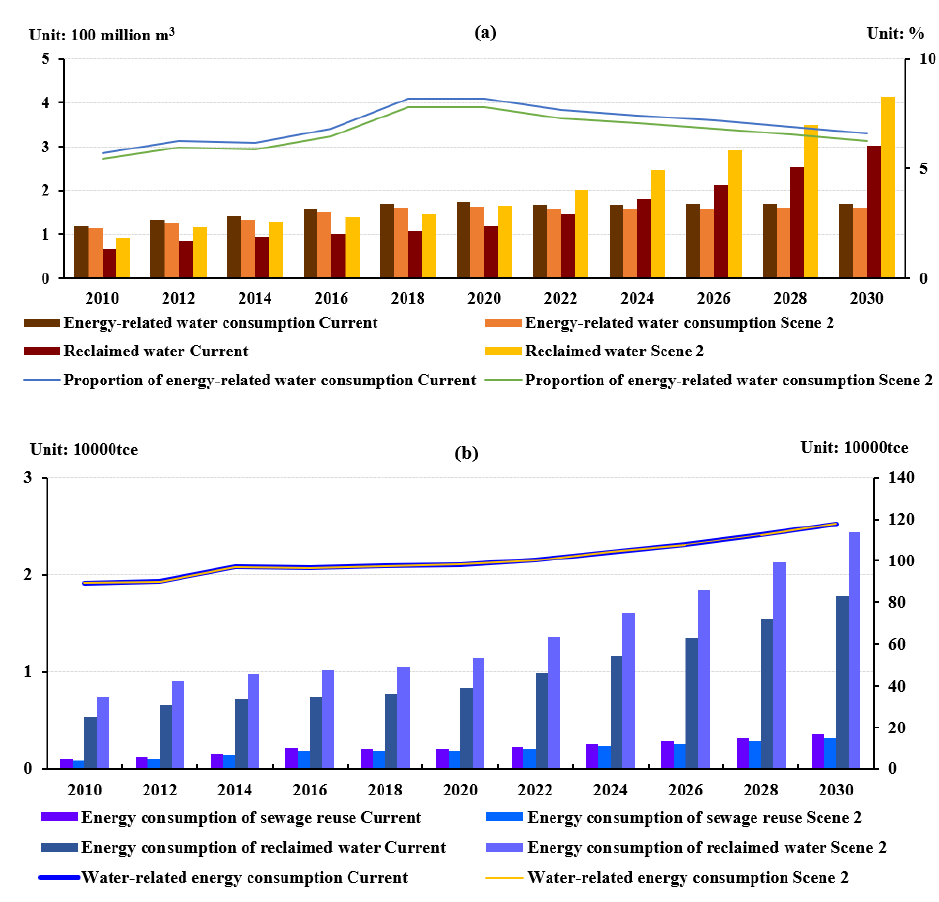
Figure 7. Simulation results of water-related indicators and energy-related indicators under ESS: ( a ) water-related indicators: energy-related water consumption, proportion of energy-related water consumption, and reclaimed water; ( b ) energy-related indicators: energy consumption of reclaimed water, energy consumption of sewage reuse, and water-related energy consumption.